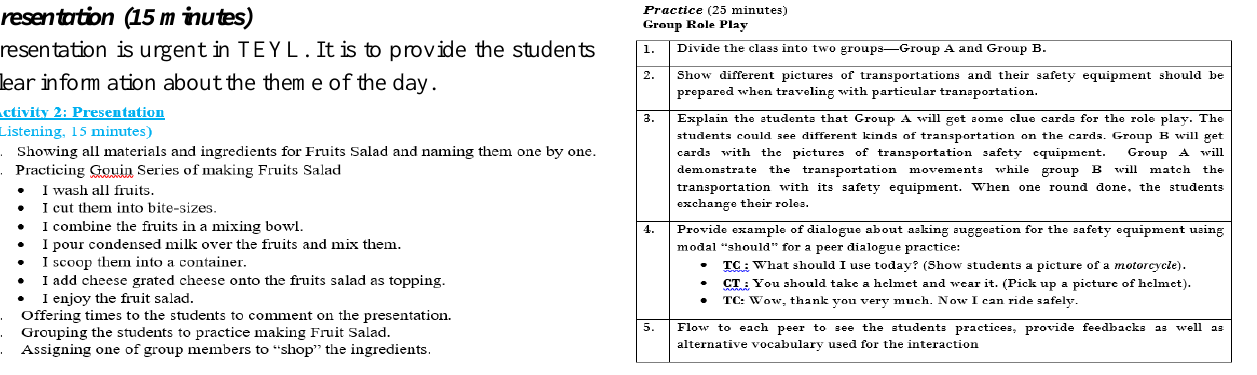
FIGURE 5 | Activity – Presentation - Gouin Seried to Make Fruits FIGURE 6 | Activity – Travelling Safety Role Play